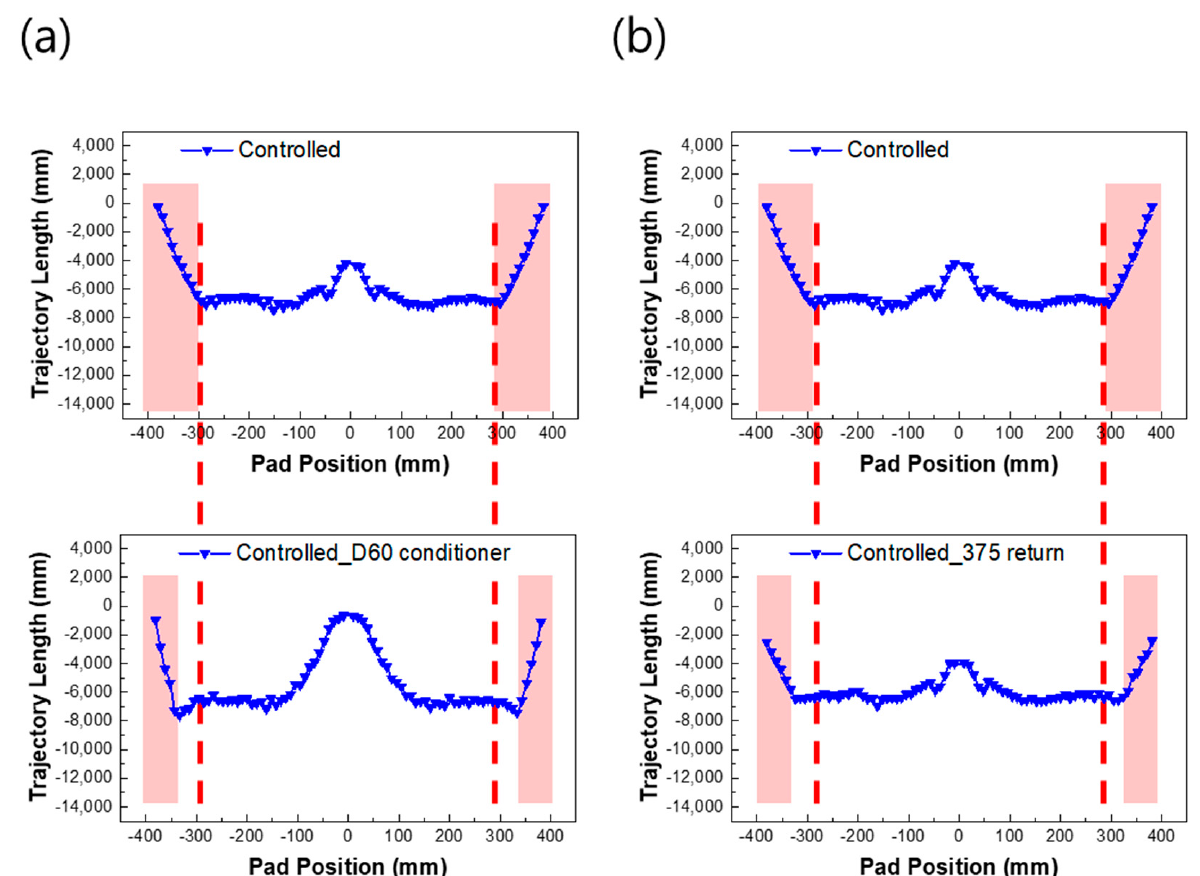
Figure 10. Results of comparing predicted shapes ( a ) Conditioner disc diameter; 100 mm (top), 60 mm (bottom), ( b ) Disc returning position; 350 mm (top), 375 mm (bottom).